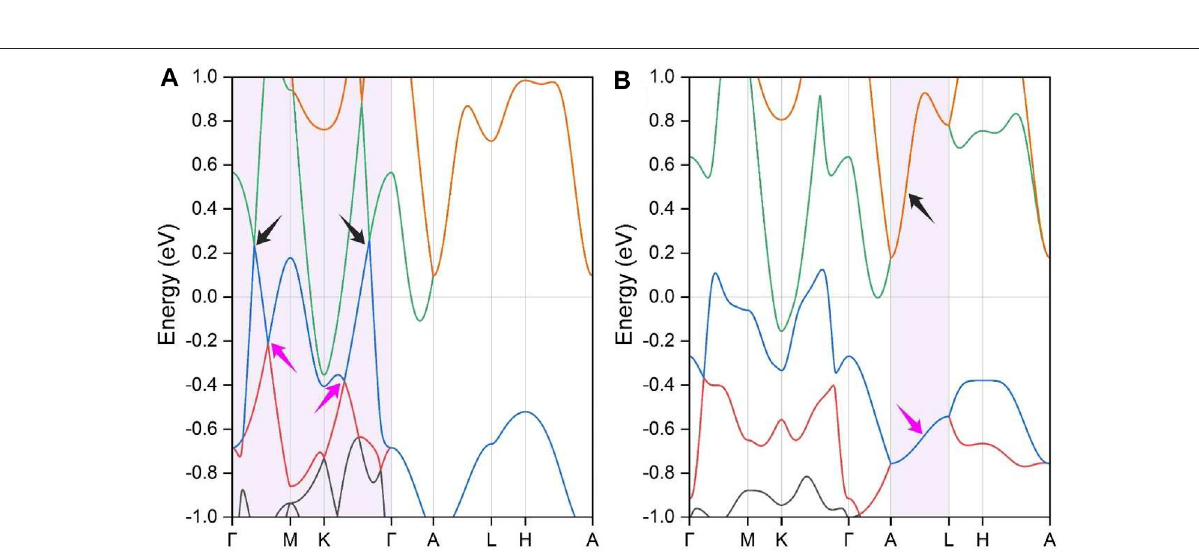
Frontiers in Chemistry |